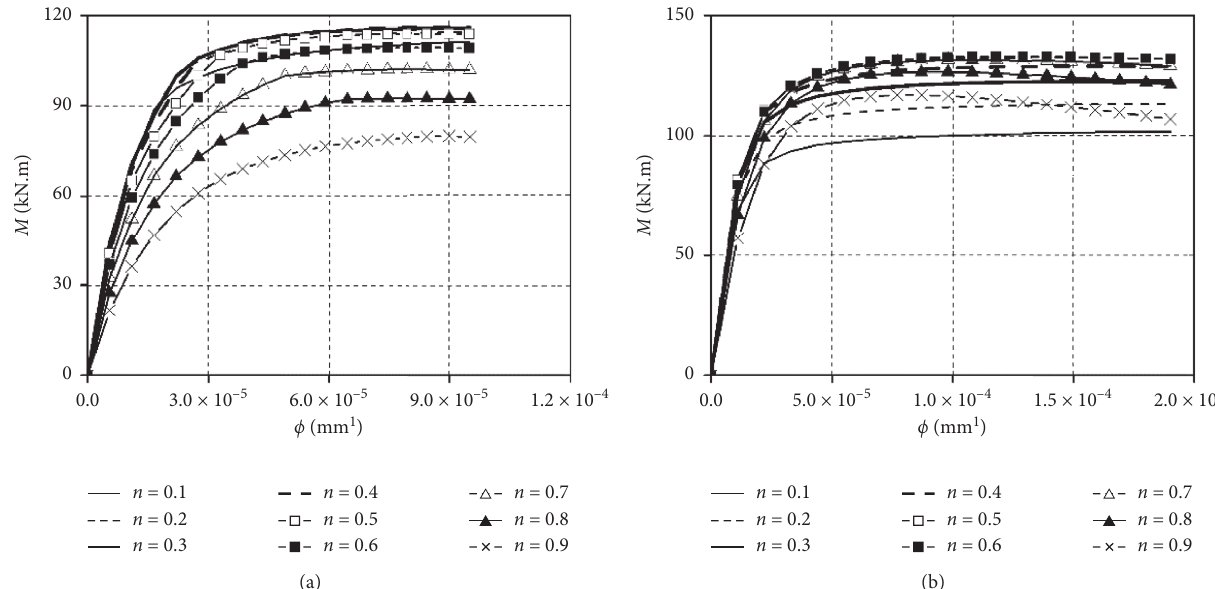
Figure 7: Cross-sectional ( M )- ϕ relation curves. (a) Forward loading. (b) 45-degree angle loading.